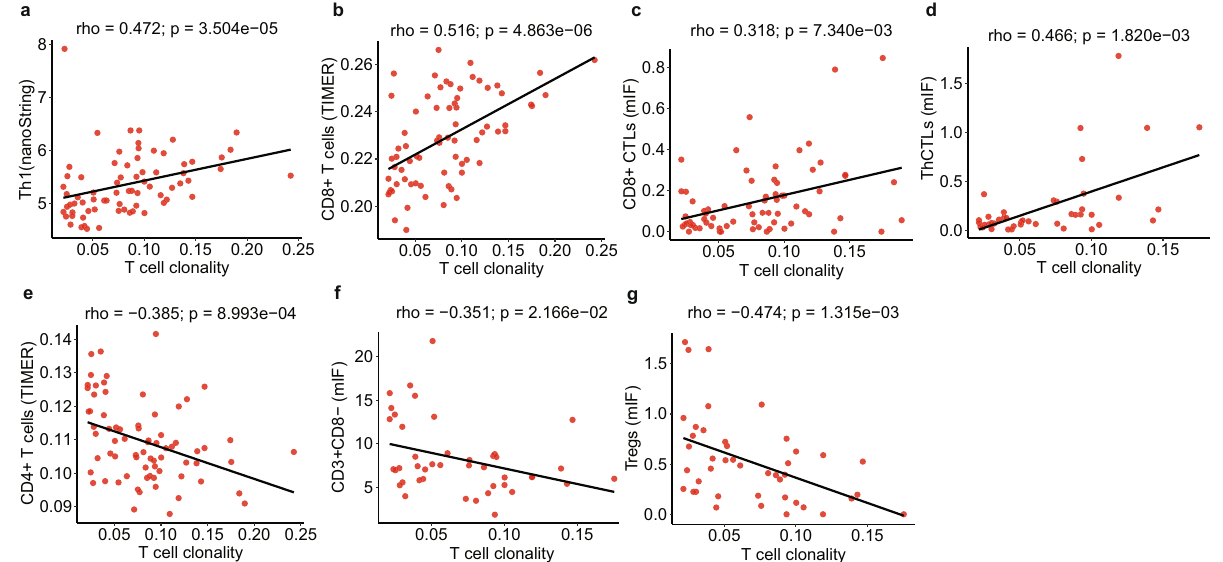
Fig. 4 The correlation between T cell clonality and T cell subtypes. a Th1 (average value of marker genes IFNG, IL12A, IL12B) measured by gene expression from nCounter PanCancer Immune Pro fi ling Panel. Fractions of CD8 + T cells ( b ) and CD4 + T cells ( e ) inferred from gene expression pro fi ling using TIMER. c CD8 + CTLs (CD3 + CD8 + granzyme B + ), d ThCTLs (CD3 + CD8 – Granzyme B + ), f CD3 + CD8 – T cells, and g Tregs (CD3 + CD8 – FoxP3 + ) measured by mIF. The correlation coef fi cient (rho) was assessed by two-tailed Spearman ’ s rank correlation test. Data from 35 patients was used including NL (normal lung tissue), AAH (atypical adenomatous hyperplasia), AIS (adenocarcinoma in situ), MIA (minimally invasive adenocarcinoma), and ADC (invasive adenocarcinoma). (Source data is provided as a source data fi